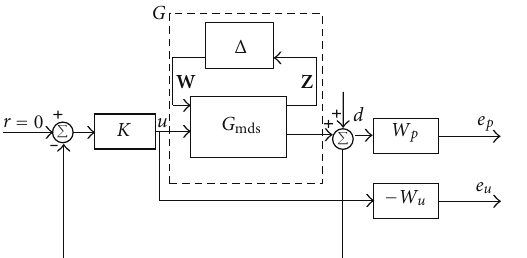
Figure 2: Block scheme of plant with the introduction of weighting functions as further outputs.